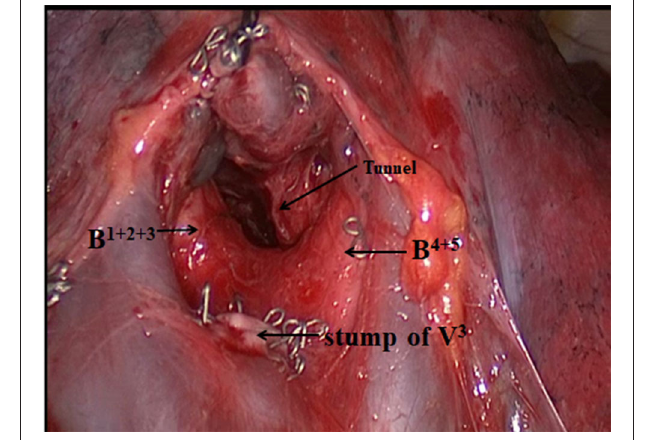
widened intercostal spaces. The surgeon and assistant stood in front of the patient.